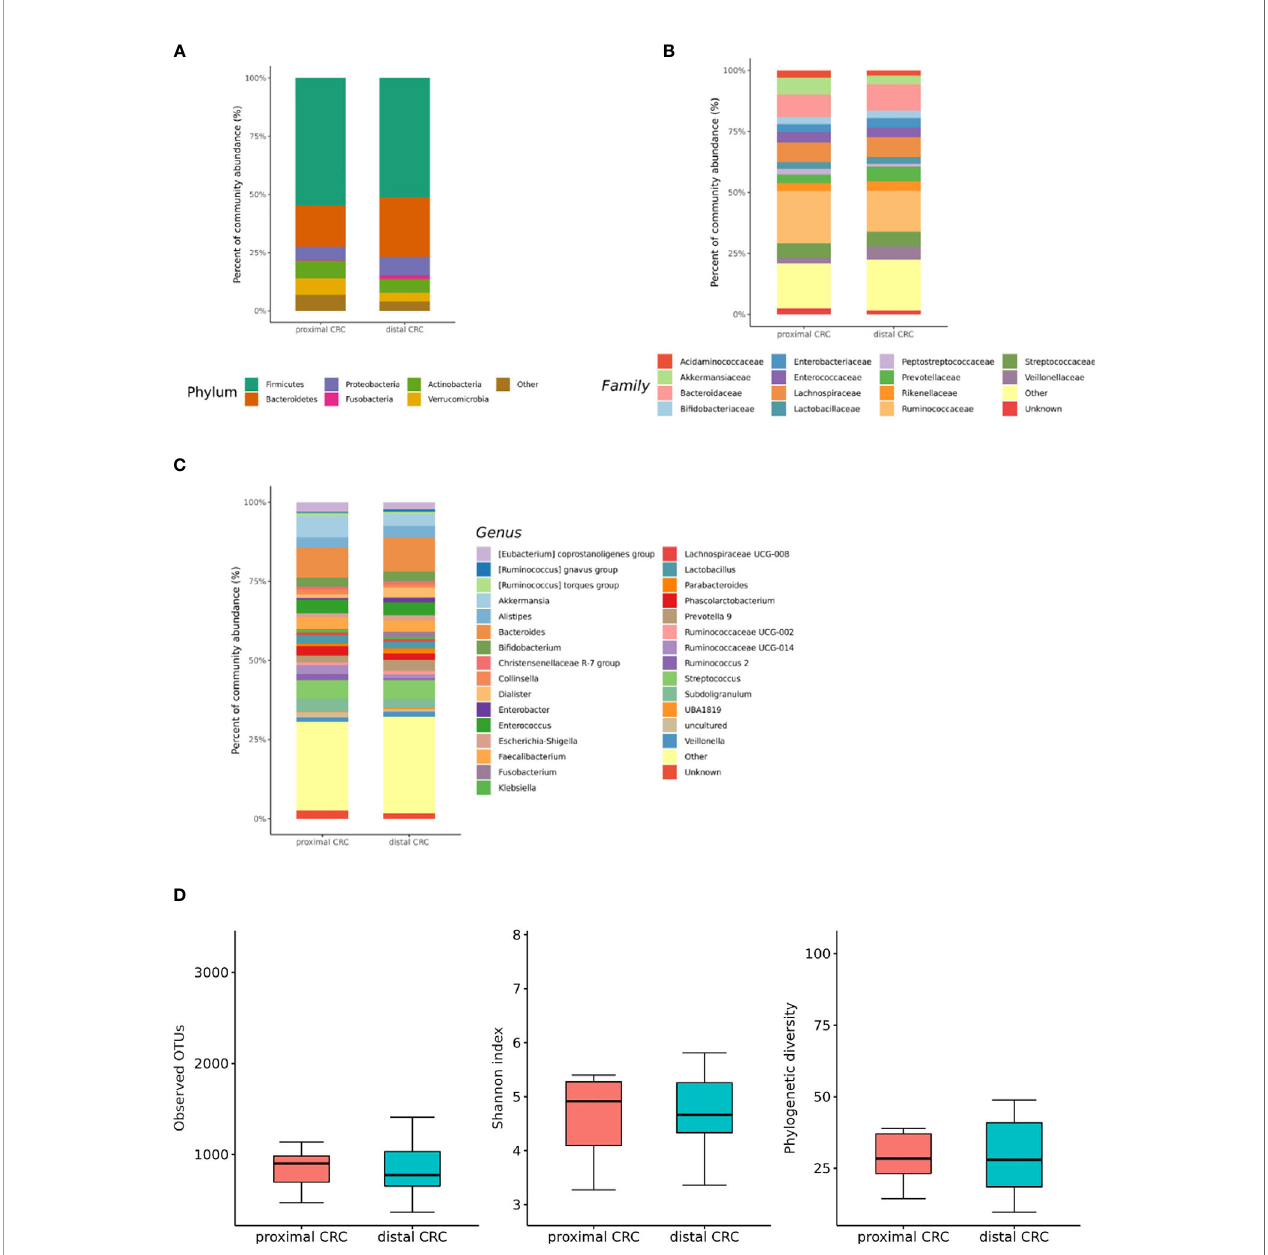
FIGURE 7 | Relative abundance plots of the gut microbiota of proximal CRC (n = 20) versus distal CRC (n = 50) (A) at the phylum, (B) family, and (C) genus levels. (D) Boxplots of alpha diversity indices comparing distal CRC with proximal CRC in the gut microbiota. CRC; colorectal cancer, OTU; operational taxonomic